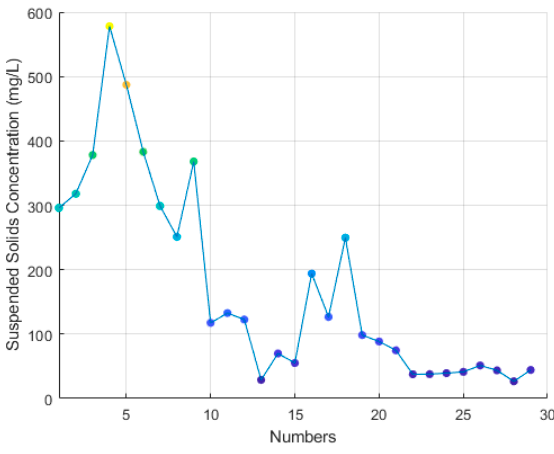
Figure 8. Results of the SSC laboratory testing. Table 3. Descriptive statistics for the SSC of the water samples from the SP dataset.